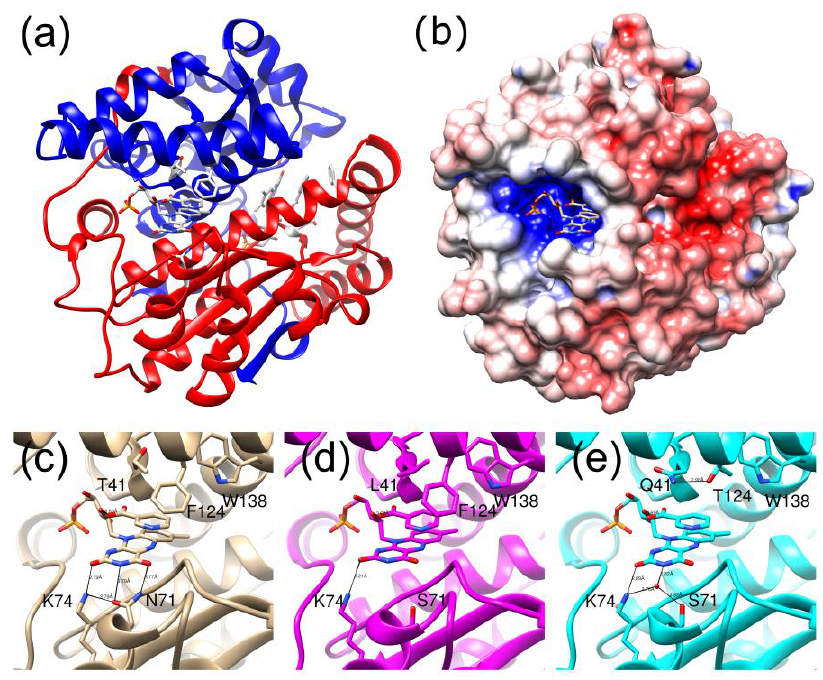
Figure 1. Structure of E. coli NfsB wild-type and mutants bound to nicotinic acid. ( a ) Ribbon diagram of wild-type enzyme from 1ICR [30]. One subunit is coloured red, the other blue. The FMN, bound nicotinic acid, and mutated sites are shown in full and in white with CPK colours. ( b ) Electrostatic surface representation of the protein in the same orientation as in ( a ). Negative charges are shown in red and positive charges in blue. ( c ) close up of the active site of the wild-type protein, in the same orientation as in ( a ) with the FMN, nicotinic acid, mutated sites, as well as the neighbouring K74 and W138, shown in full in CPK colours. Hydrogen bonds between residues are shown with black lines. ( d ) The same region as in ( c ) in the T41L/N71S mutant. ( e ) The same region as in ( c ) in the T41Q/N71S/F124T mutant.